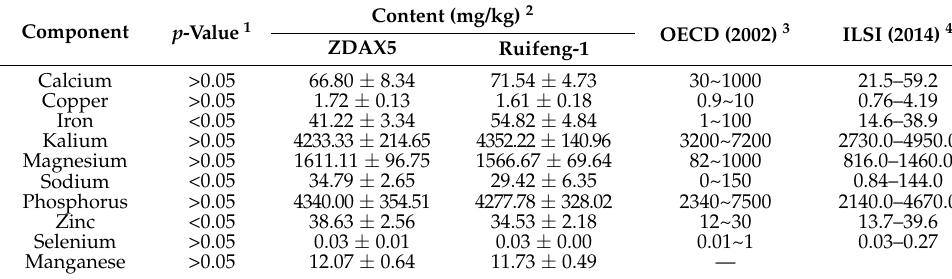
Table 5. Mineral levels in ZDAX5 maize grain and Ruifeng-1 maize